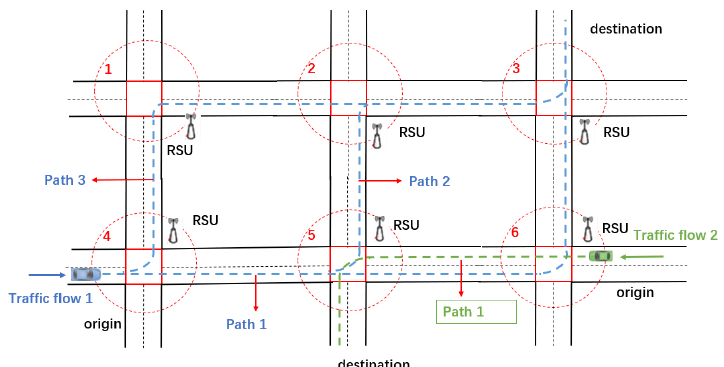
Figure 8. Illustration of two typical traffic flows in a road network. Numbers 1-6 indicate the intersection number.